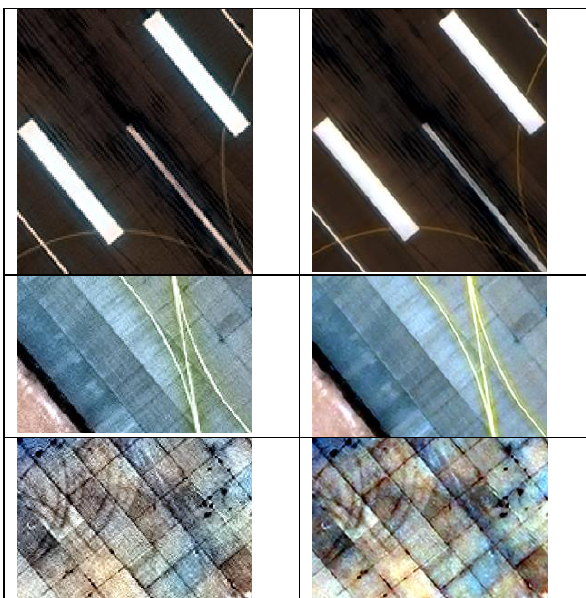
Figure 12. MAXAR 30 cm (left) and 15 cm (right) image parts over Al Jufra airport.